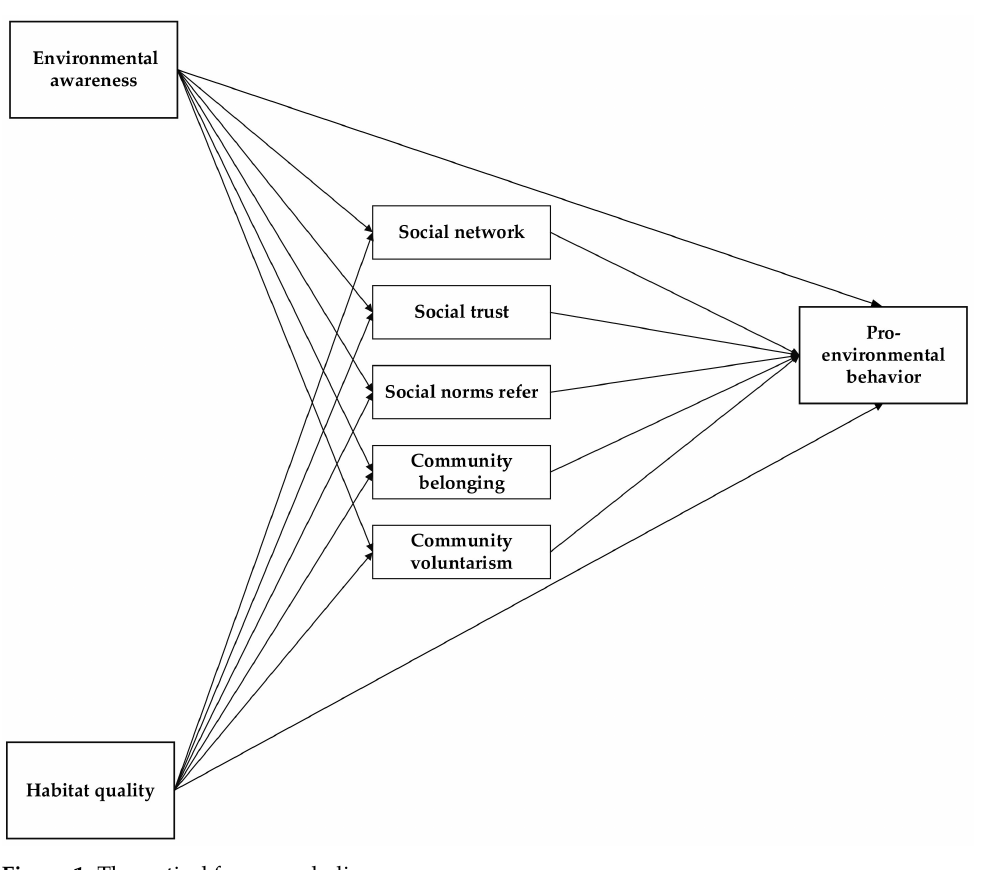
Figure 1. Theoretical framework